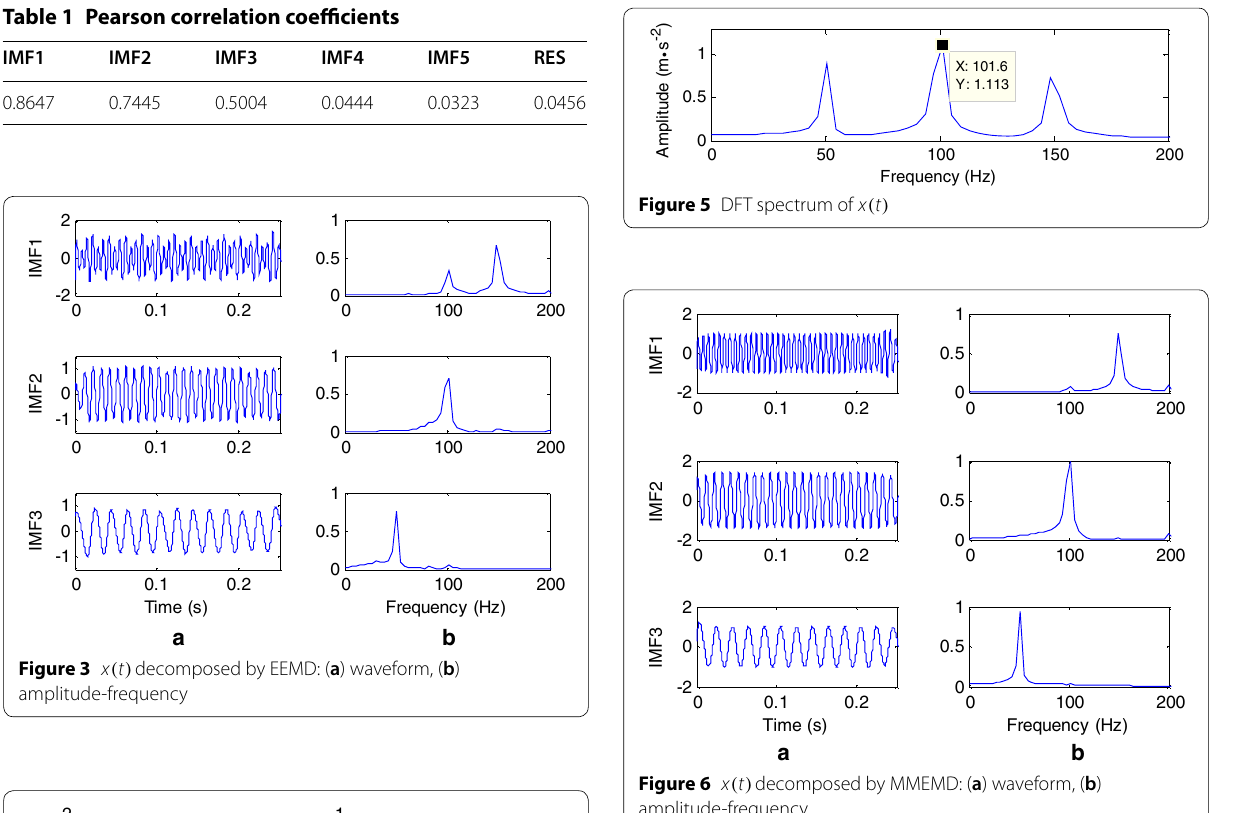
Figure 6 x ( t ) decomposed by MMEMD: ( a ) waveform, ( b ) amplitude-frequency